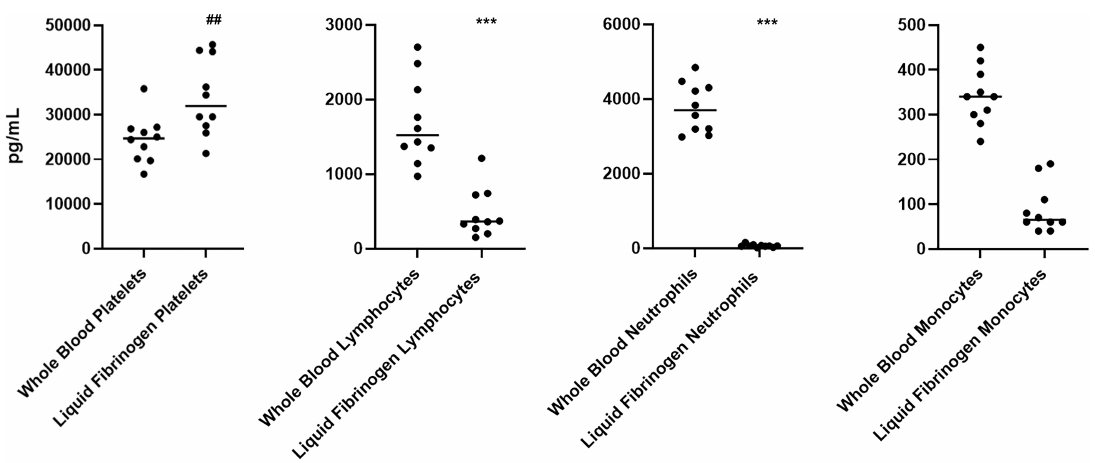
Figure 2. Cell count test on volunteers’ whole blood and liquid fibrinogen. The accumulation of platelets, lymphocytes, neutrophils, and monocytes is reported. Each data point, within any single experiment, is the mean (± SD) of three independent replicas. ## p < 0.01; *** p < 0.001.